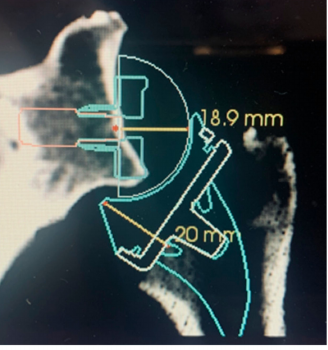
Figure 9. Gap space requirement for reduction of a standard 36 mm GS with a standard insert (+6 mm) and tray (+0 mm). Baseplate/GS distance of approximately 18.9 mm and insert/tray jump distance of 20